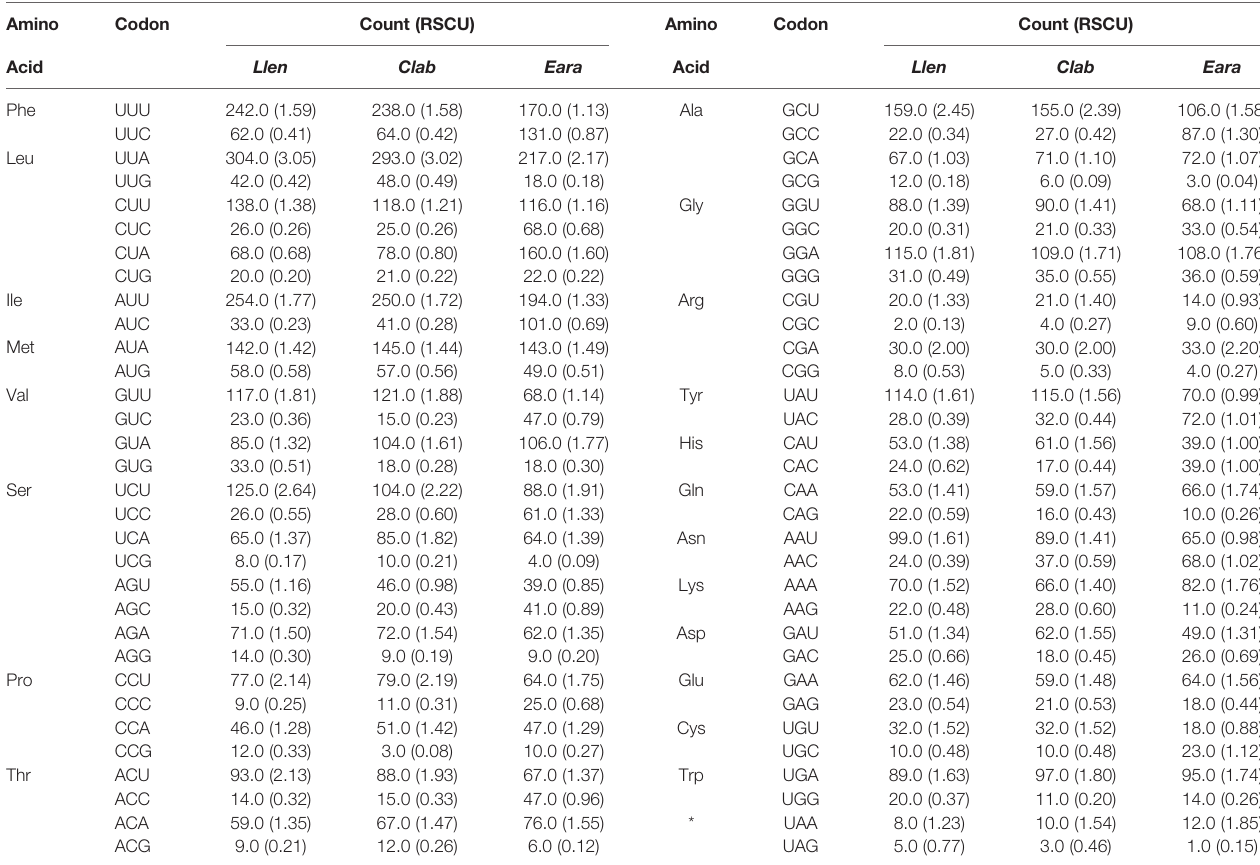
TABLE 4 | Codon and relative synonymous codon usage (RSCU) of 13 protein-coding genes (PCGs) in the mt genomes of Lentigo lentiginosus , Canarium labiatum , and Euprotomus aratrum